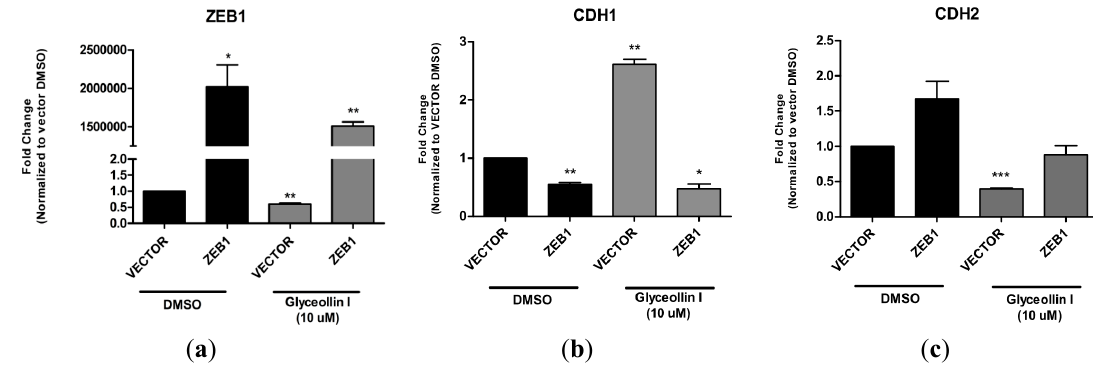
Figure 7. Overexpression of ZEB1 abrogrates the effects of Glyceollin I. Total RNA was isolated from LTLT-Ca vector cells or LTLT-Ca ZEB1 transfected cells, reverse transcribed into cDNA and subjected to quantitative real time RT-PCR analysis. Both LTLT-Ca vector and LTLT-Ca-ZEB1 transfected cells were treated with either DMSO vehicle (as demonstrated by the solid black bars), or 10 μ M stimulation with Glyceollin I (as demonstrated by the solid gray bars) and mRNA expression was measured for ( a ) ZEB1; ( b ) CDH1; and ( c ) CDH2. Bars represent mean normalized gene expression compared to vehicle treated LTLT-Ca vector control. Results are expressed as the mean unit ± SEM (*** p < 0.001; ** p < 0.01; * p < 0.05) for three independent experiments.